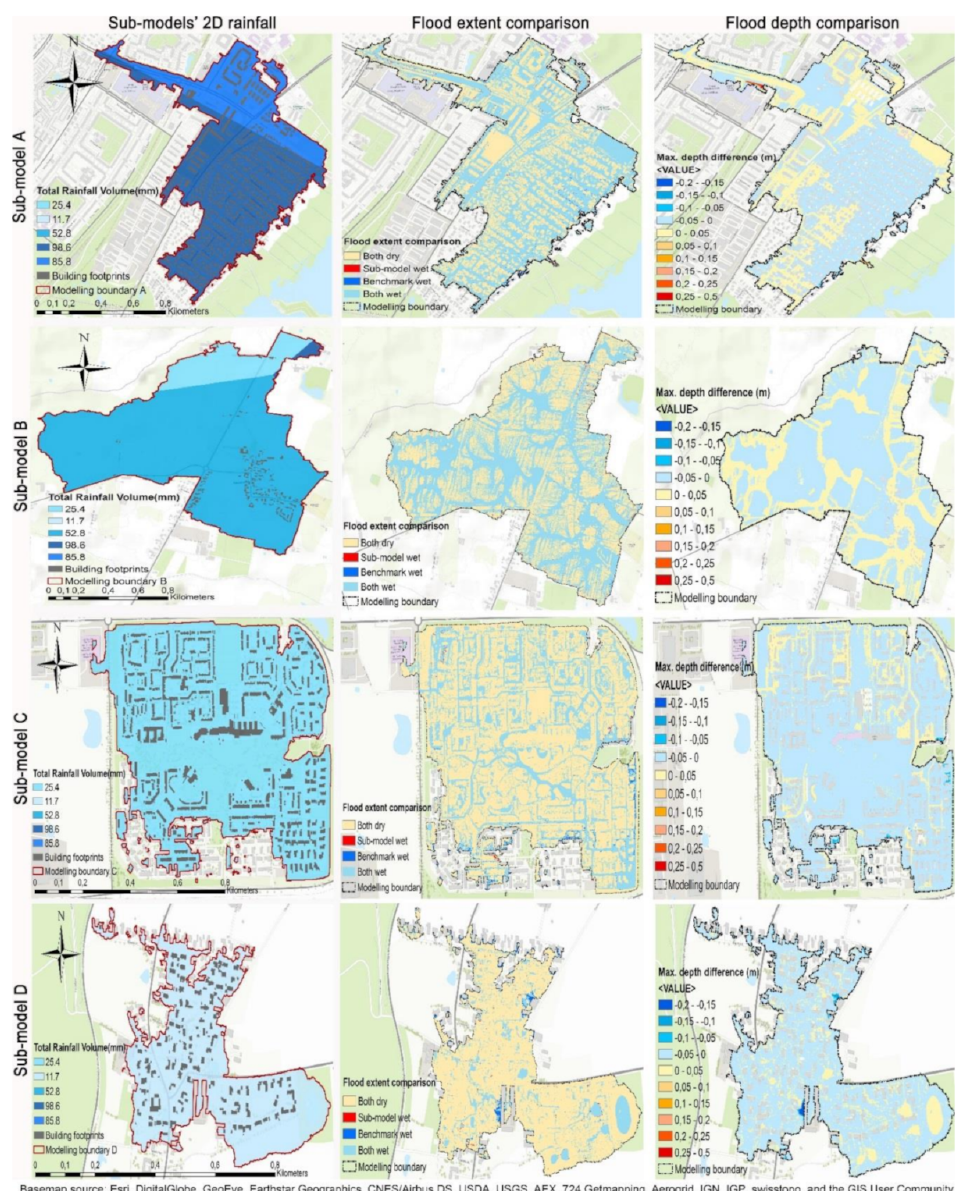
Figure A2. The first column represents the reduced 2D rainfalls associated with different data volumes in dfs2 file (MIKE FLOOD 2D’s input file format); the second column represents maximum depth flood extent’s categorised maps for four sub-models and the third column represents maximum depth’s depth difference map for four